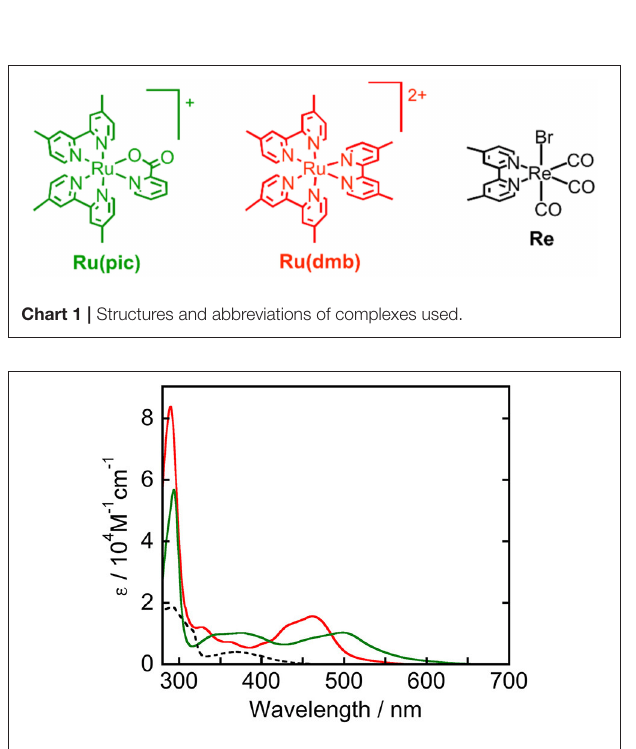
Frontiers in Chemistry |